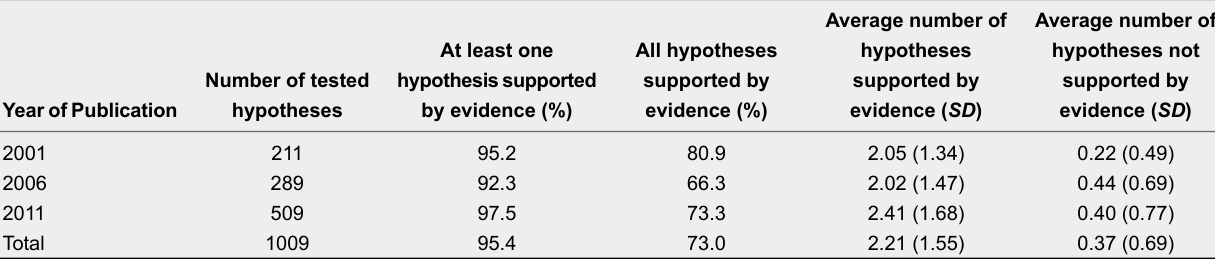
Number of Hypotheses Supported and not Supported by